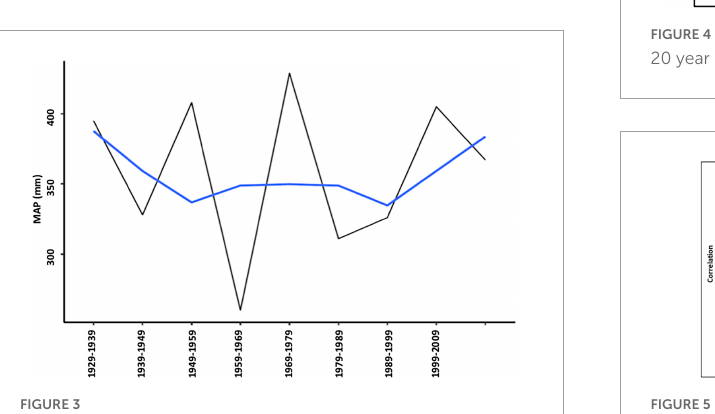
FIGURE3 Interdecadal rainfall variability 1929–2020.